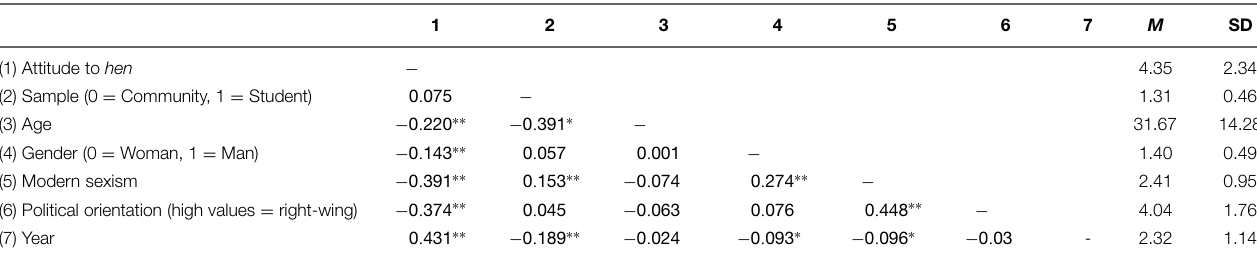
TABLE 4 | Correlations, means, and SDs for variables included in